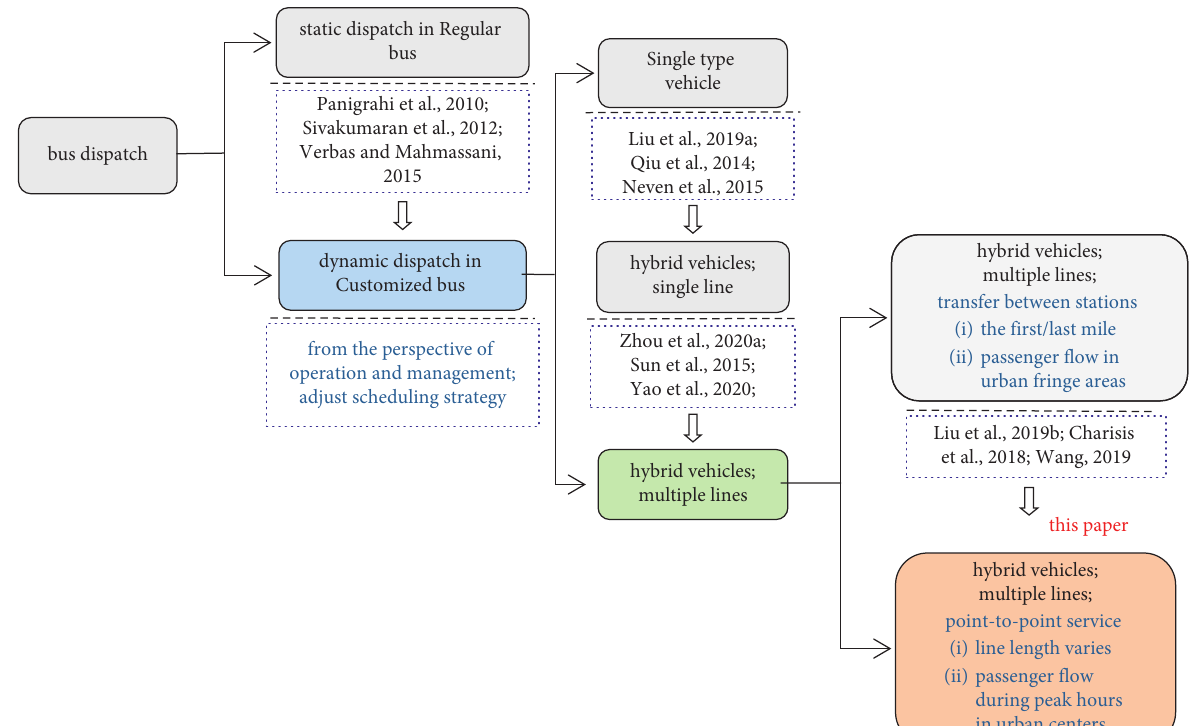
Figure 1: Research direction of bus